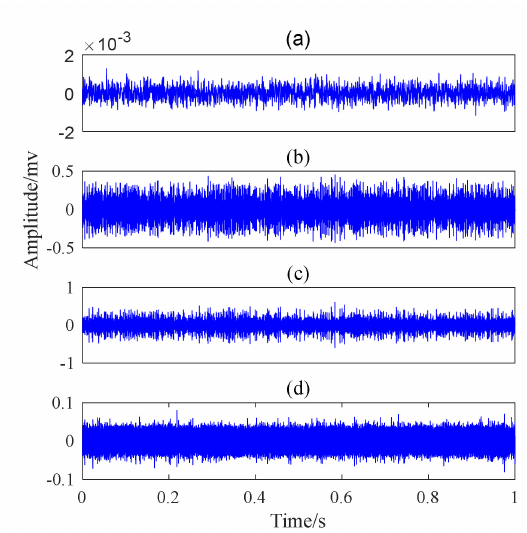
Figure 22. The IMFs of the collected signal of bearing with 1 mm outer race fault processed by the Improved EWT method: ( a ) IMF1; ( b ) IMF2; ( c ) IMF3; ( d ) IMF4.